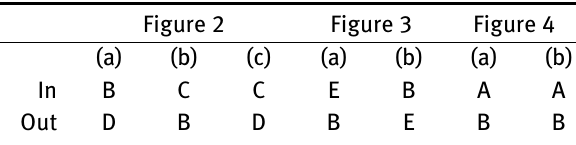
Table 2: Each of the examples in Figures 2 – 4 corresponds to a combination of input and output subtracks, defined by cases A – E as given by Table 1.